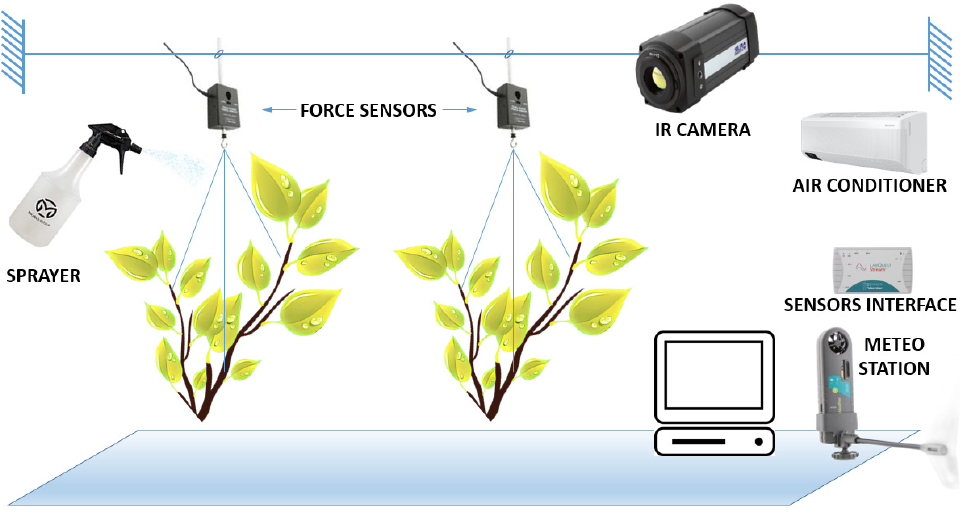
Figure 1. Sketch of the experimental